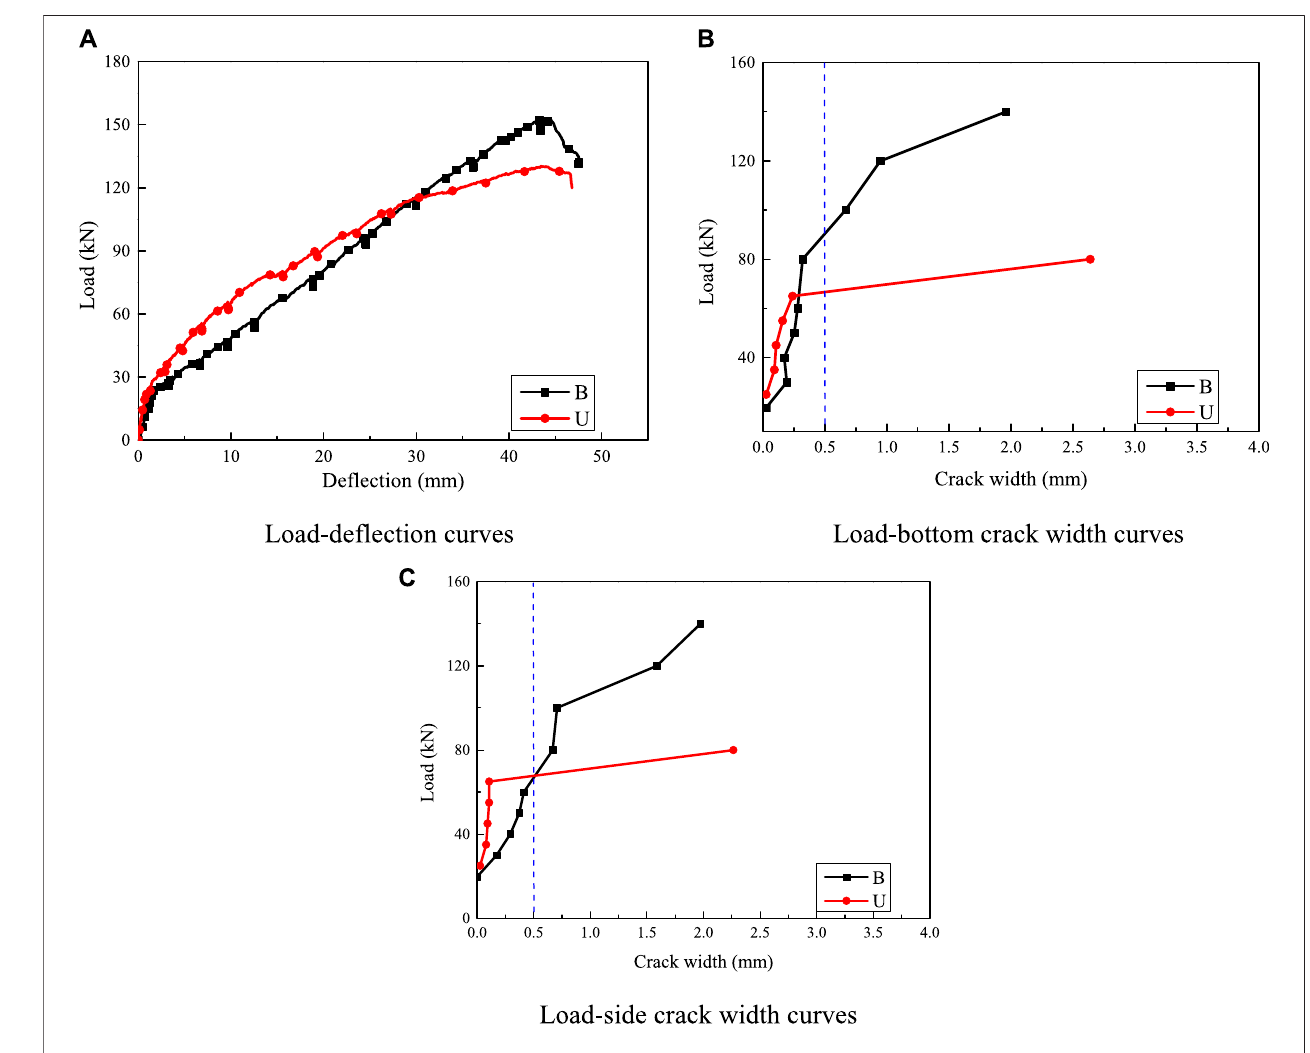
FIGURE 11 | Effect of the formwork